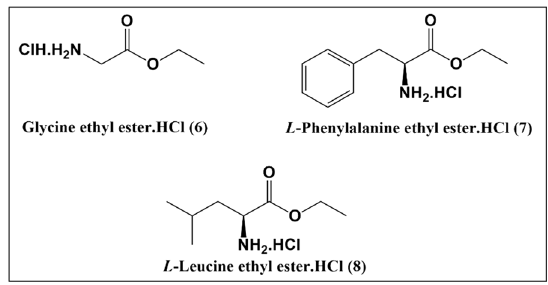
Fig. 5 Structures of the compounds 6 , 7, and